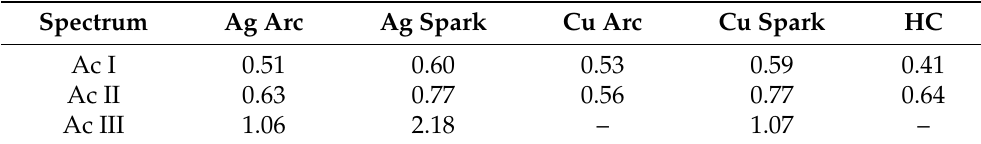
Table 9. Effective excitation temperatures (in eV) in the light sources used by Meggers et al. [9], determined from Boltzmann